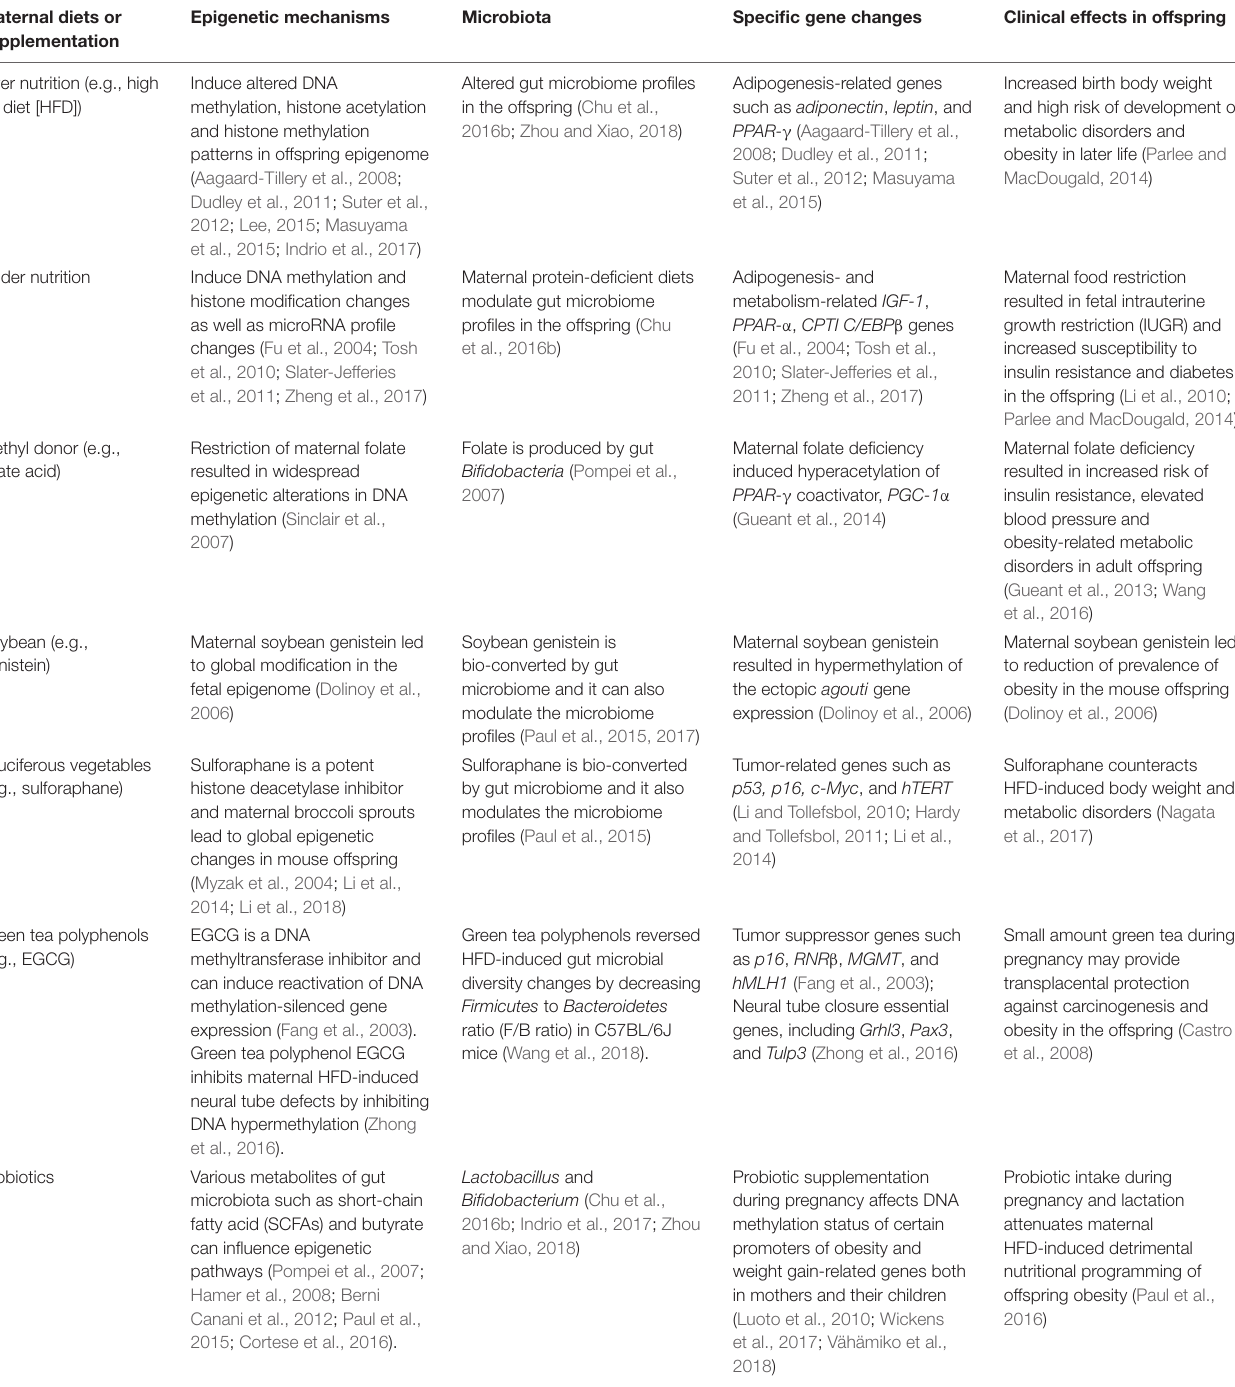
TABLE 1 | Maternal dietary factors link epigenetics and microbiome to obesity in the